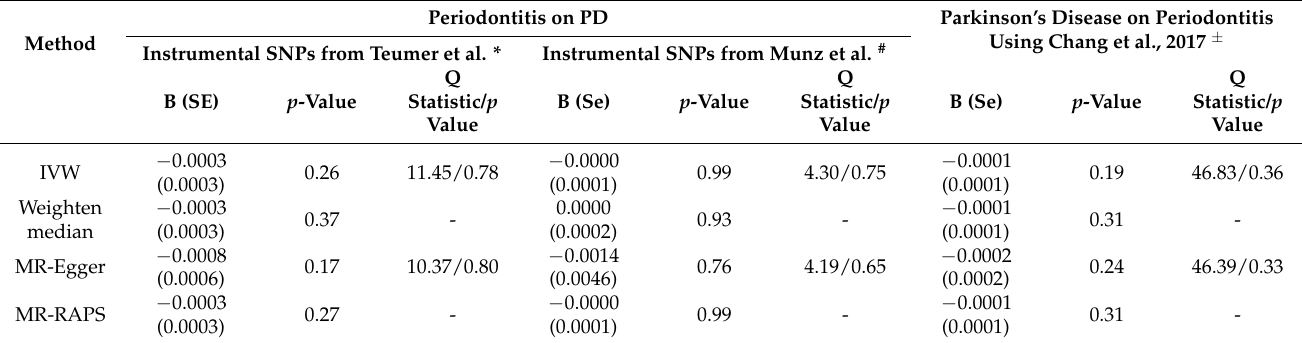
Table 1. Mendelian randomization results for the association between PD and periodontitis.